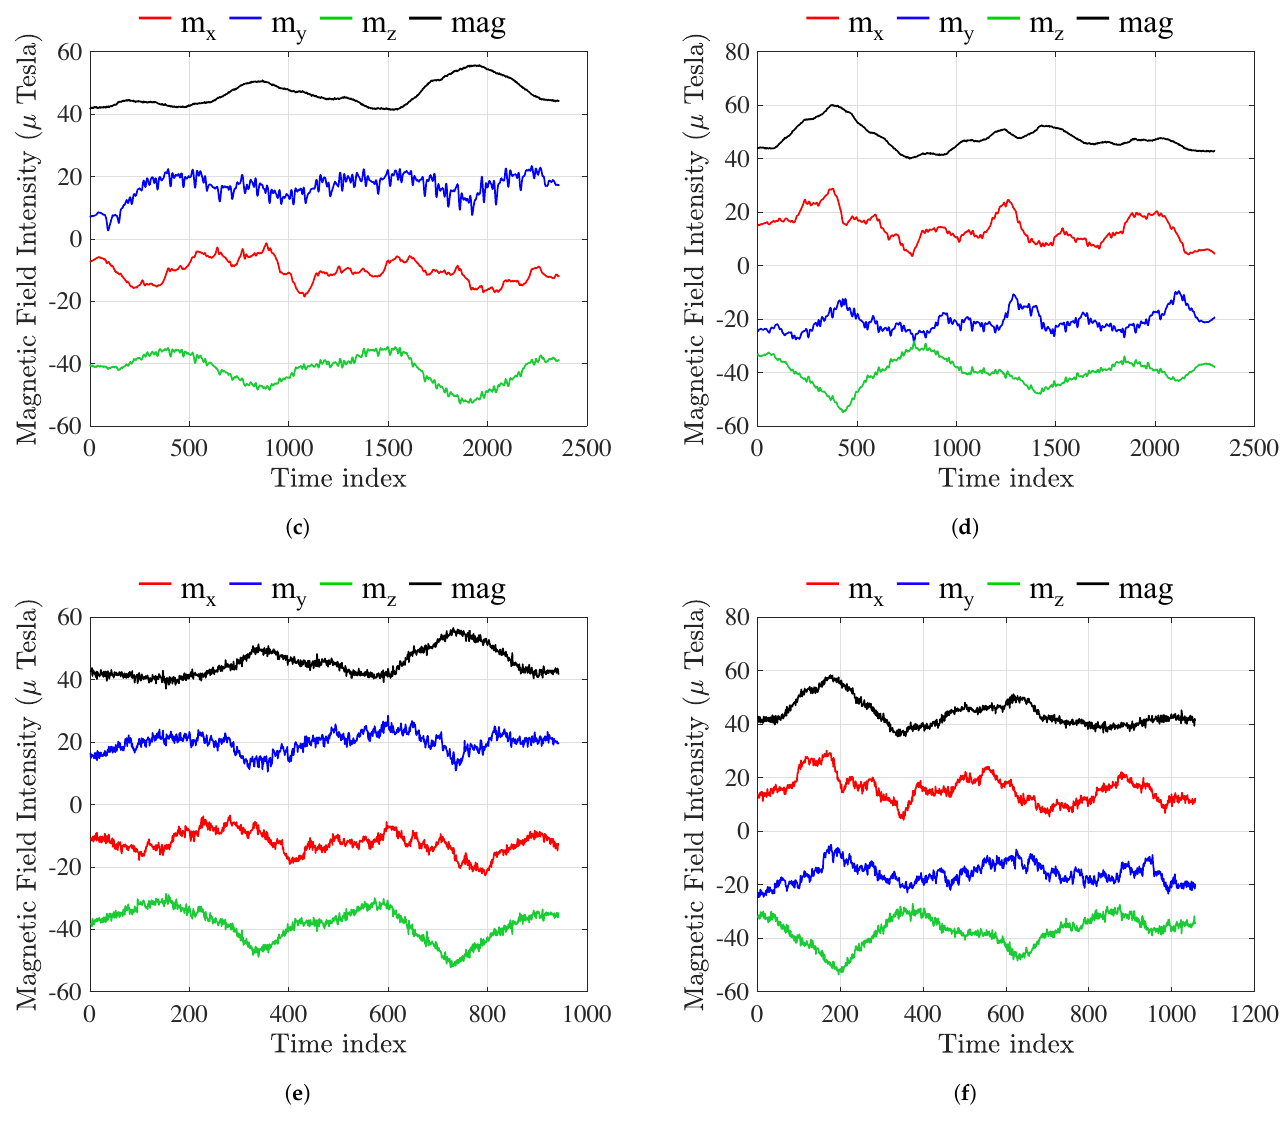
Figure 1. Magnetic field measurements of heterogeneous smartphones in the same corridor. ( a ) iPhone 12 Mini forward; ( b ) iPhone 12 Mini backward; ( c ) iPhone Xs Max forward; ( d ) iPhone Xs Max backward; ( e ) Redmi Note 7 forward; ( f ) Redmi Note 7